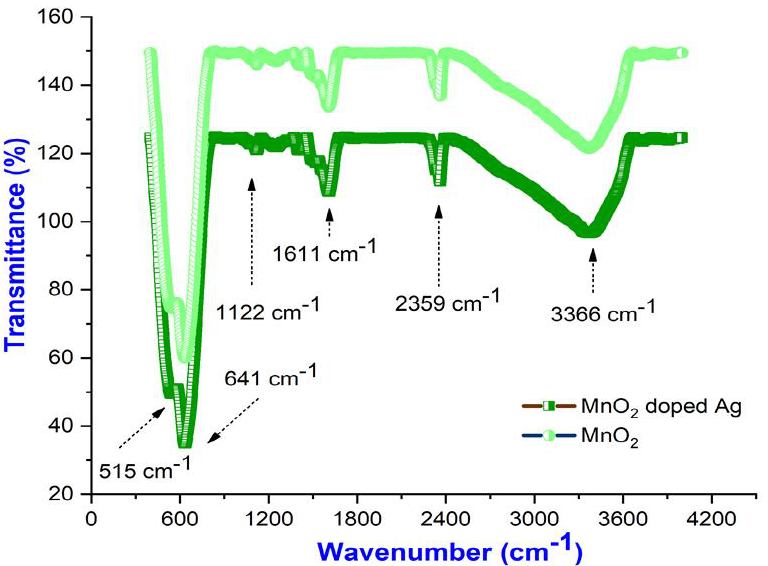
Figure 4. FTIR spectrum of synthesised pure MnO 2 and MnO 2 doped with Ag nanoparticles.